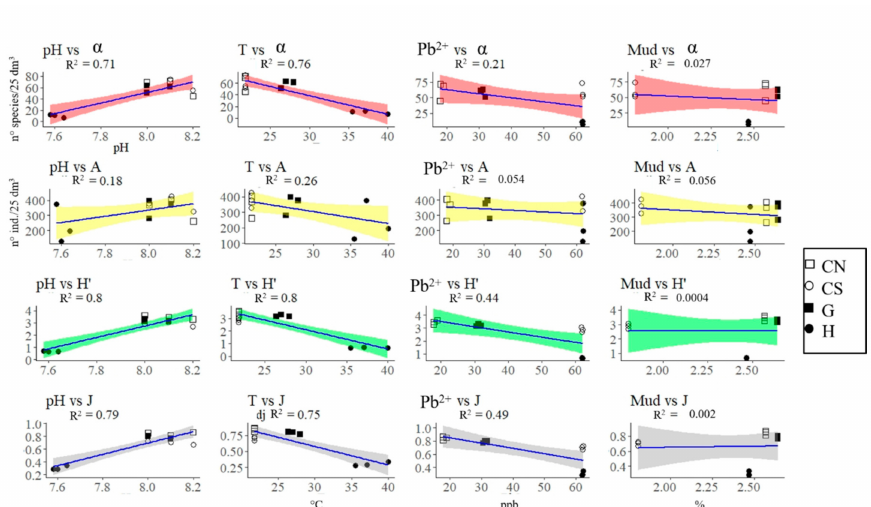
Figure 9. Linear regression models between environmental parameters (independent variables) and synecological indices (dependent variable) of Nematoda assemblages. In red—relations among environmental variables and α -diversity ( α ); in yellow—relations among environmental variables and abundances (A); in green—relations among environmental variables and diversity index (H’); in grey—relations among environmental variables and evenness (J). Significant R 2 is also shown for each